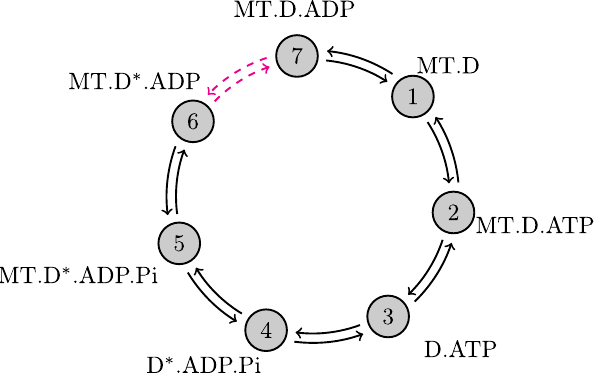
FIG. 8. Sketch of the chemomechanical ring network for dynein with visible transitions 6 ↔ 7 . The meaning of the transitions between each state and the experimentally inferred values of the transition rates are listed in Table I.